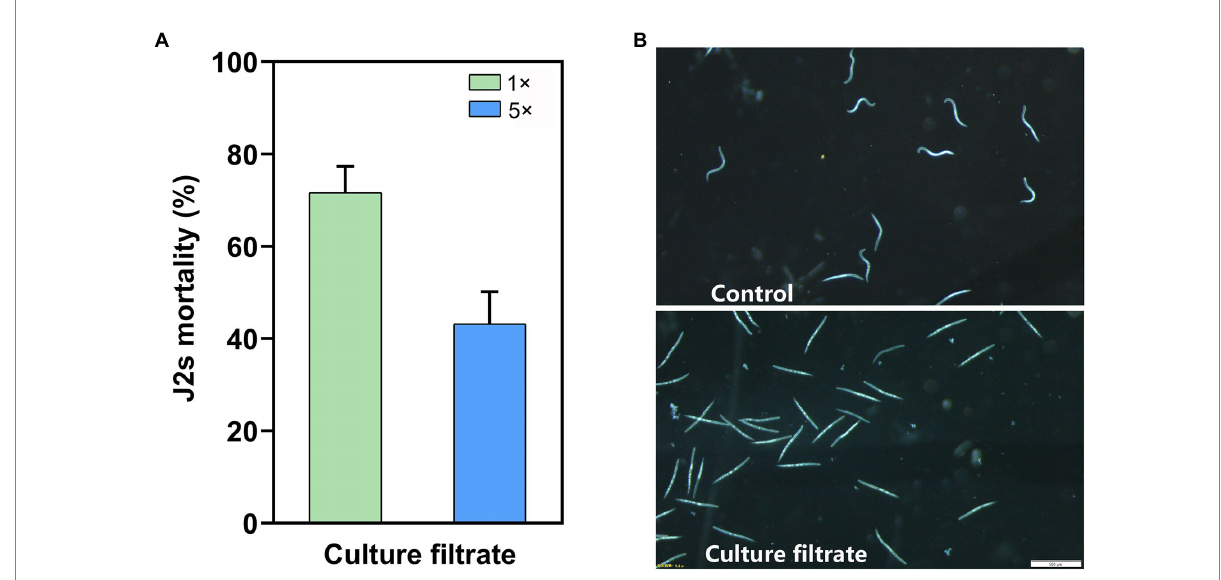
FIGURE 1 Filtrate culture of Bacillus velezensis YS-AT-DS1 ( Bv-DS1 ) affected the J2s mortality of M. incognita . (A) Corrected J2s mortalities of M. incognita were analysed after incubation with the 1× and 5× Bv-DS1 filtrate cultures for 24 h at room temperature. The error bars represent the mean ± SE of the data from 10 replicates. (B) Microscopic observation of J2s body immersed in Bv-DS1 filtrate culture or the sterilized distilled water after 48 h incubation. Scale bar = 500 μ